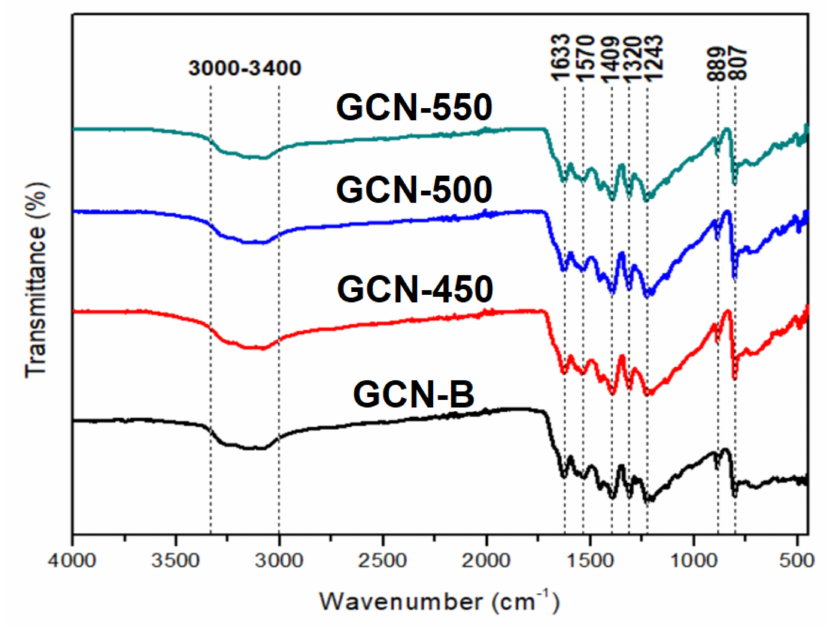
Figure 4. FTIR spectra of GCN-B and GCNs that recalcined at different